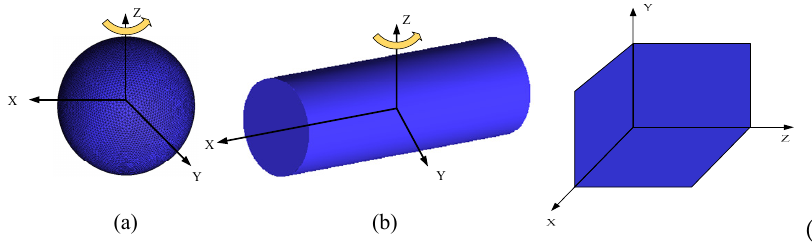
Figure 6. Three types of targets: ( a ) sphere, ( b ) cylinder, ( c ) corner reflector. Table 2. The geometry size and the number of triangular patches of three targets. Target